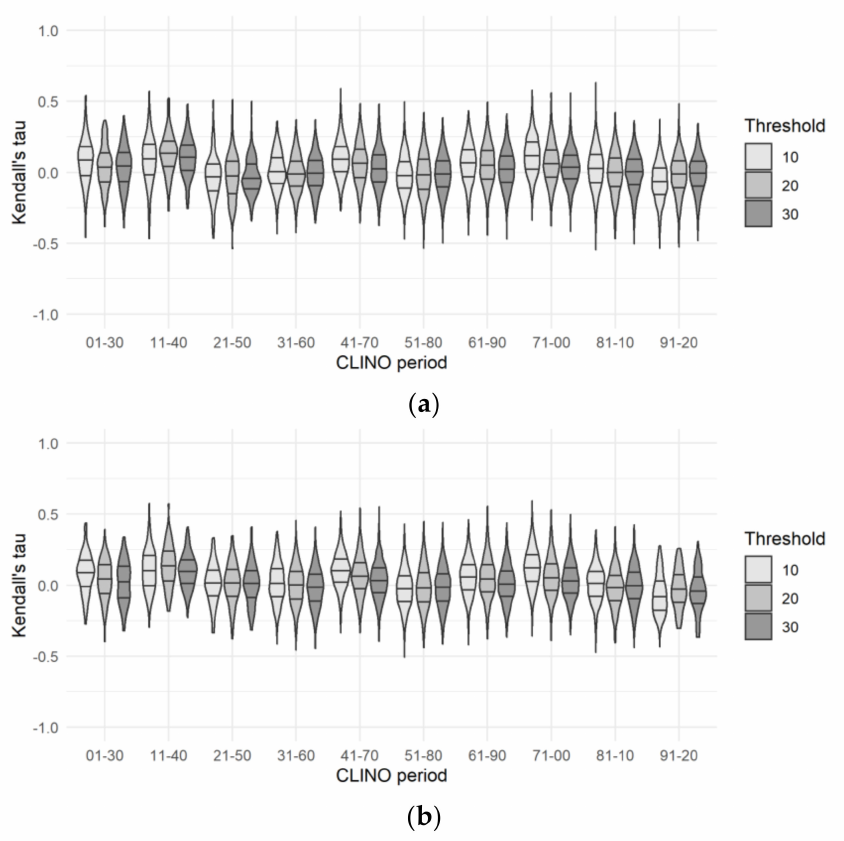
Figure A3. Distribution of Kendall’s tau for the CLINO periods since 1901 and thresholds in mm d − 1 . ( a ) shifted stations and ( b ) stable